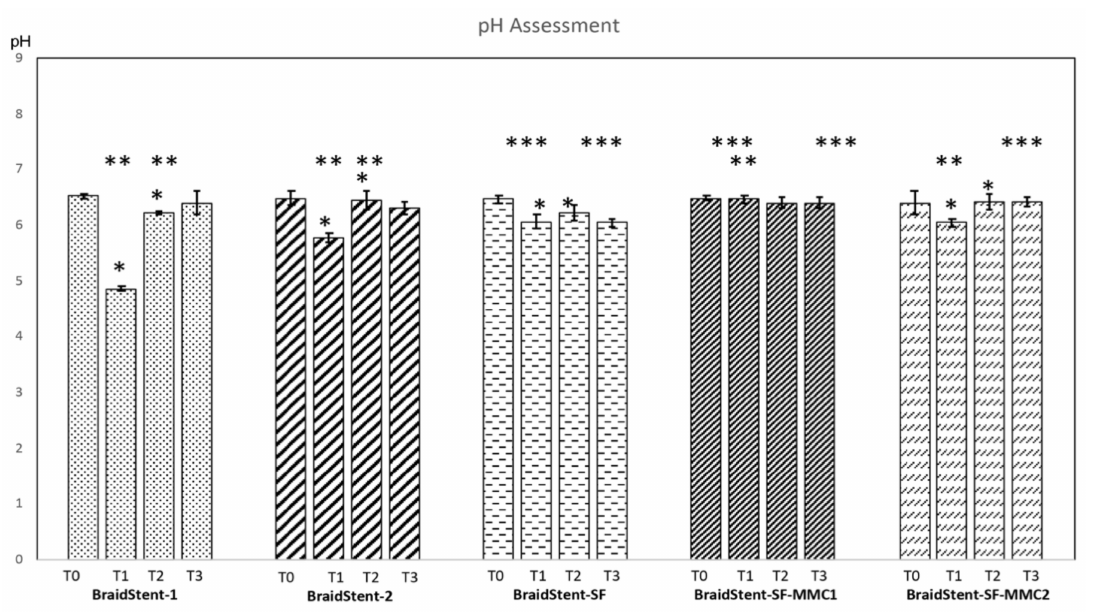
Figure 6. Assessment of pH throughout the study until complete stent degradation. T0 (start of study); T1 (onset of degradation); T2 (50% of degradation); T3 (complete stent degradation). Values indicate mean ± SD. Significance of the values between each tested groups within each phase of the study was determined by the Kruskal–Wallis H test and post hoc pairwise comparison; while a General Linear Model (GLM) Repeated Measures was used to evaluate the effect of both group and time (from T0 to T3) in the trend of pH, with the corresponding post-hoc analysis by Tukey test. Statistical significance is indicated in the figure as follows: intra-groups (* p < 0.05); inter-groups (** p < 0.05) (BraidStent-1 vs. BraidStent-2; BraidStent-SF-MMC1 vs. BraidStent-SF-MMC2); inter- groups (*** p < 0.05) (BraidStent-SF vs. BraidStent-SF-MMC1 and BraidStent-SF-MMC2). Friedman